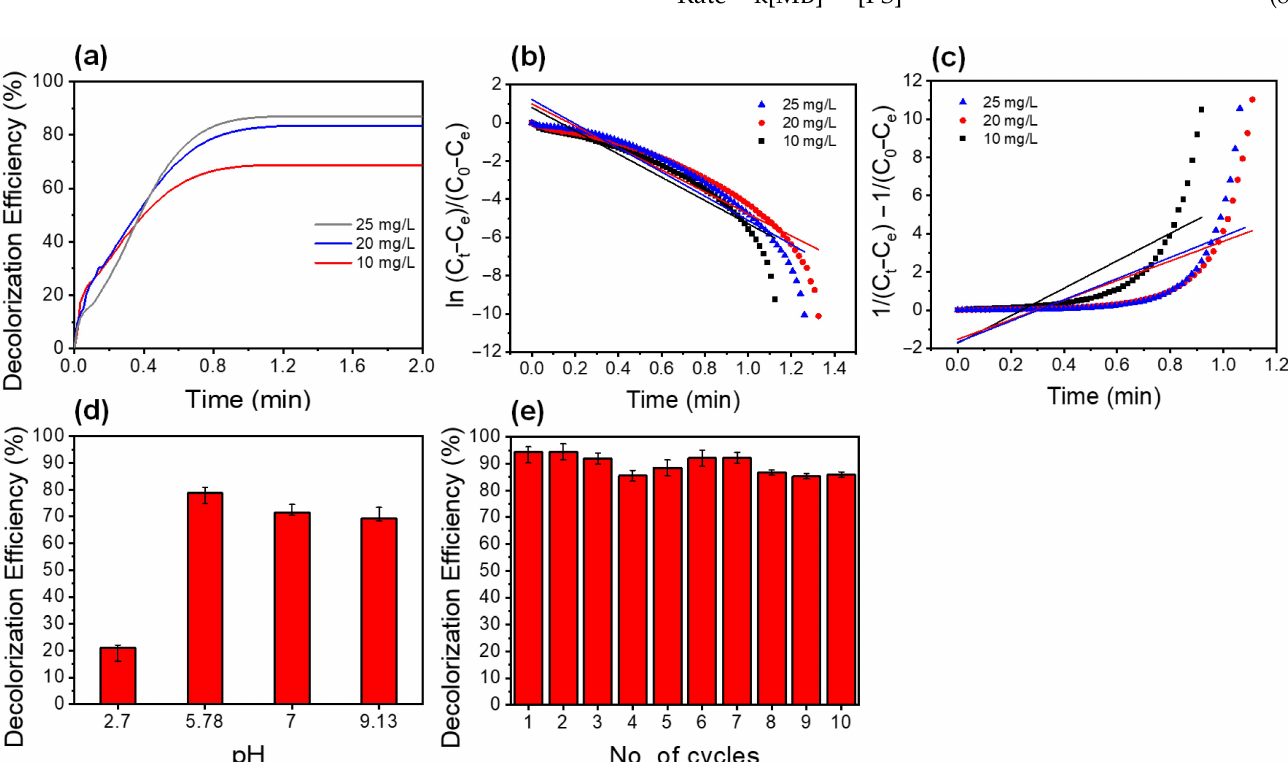
Figure 5. ( a ) Decolorization kinetics of MB at different concentrations of MB using 4 mM PS and chitosan–limonite fibers (10% limonite). Decolorization kinetics data fitted with ( b ) first- and ( c ) second-order reaction kinetic models. ( d ) Effect of pH on the decolorization efficiency (4 mM PS and chitosan–limonite fibers (10% limonite)). ( e ) The recyclability of the chitosan fibers with 10% limonite on the MB decolorization with 4 mM PS and 5 mg/L MB (plotted relative to the first cycle of the decolorization